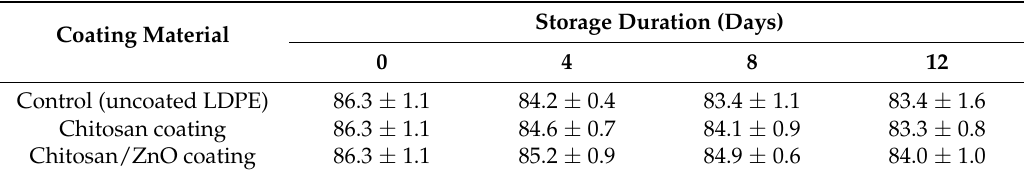
Table 3. Effect of different coatings on moisture content (%) of okra samples during different storage